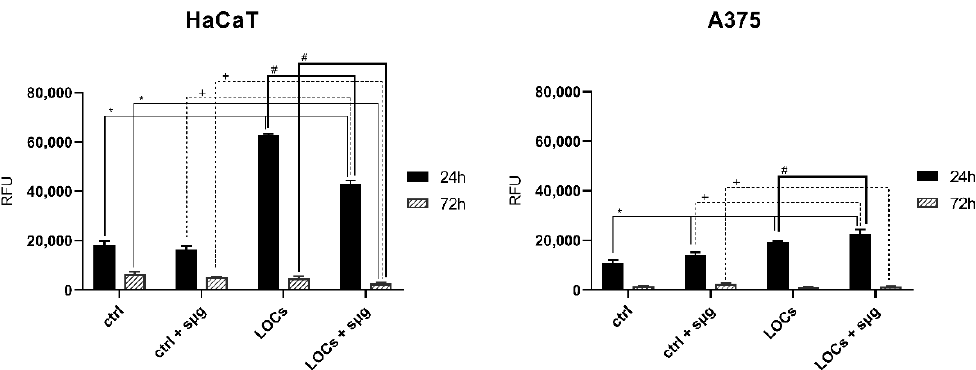
Figure 3. Caspase activity evaluation of HaCaT and A375 cells after the exposure to simulated microgravity; (RFU—relative fluorescence units). Statistically significant differences in comparison to ctrl cells: *, ctrl + sµg cells: +, and LOC cells: # ( p ≤ 0.05).